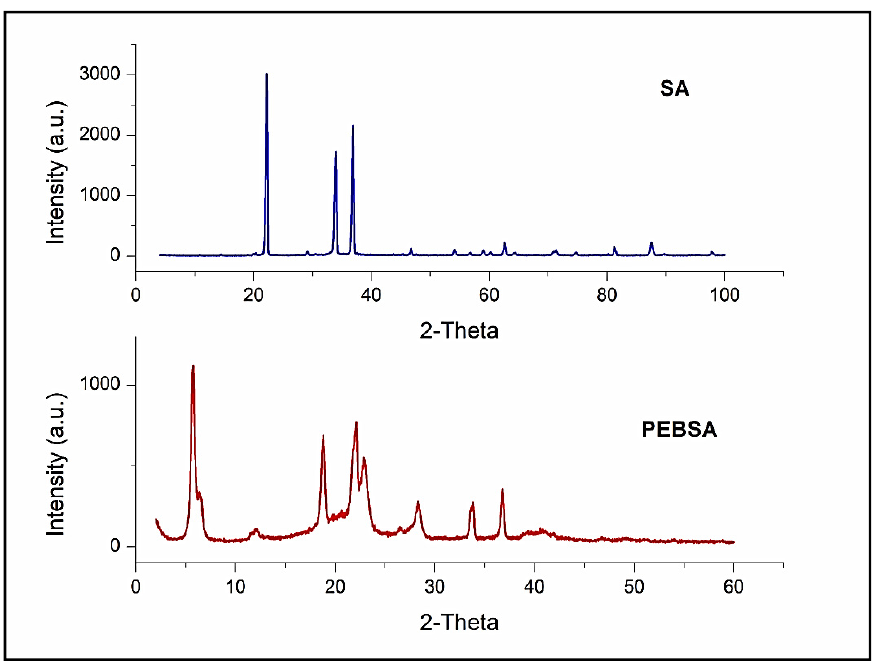
Figure 12. XRD of PEBSA and SA comonomer.